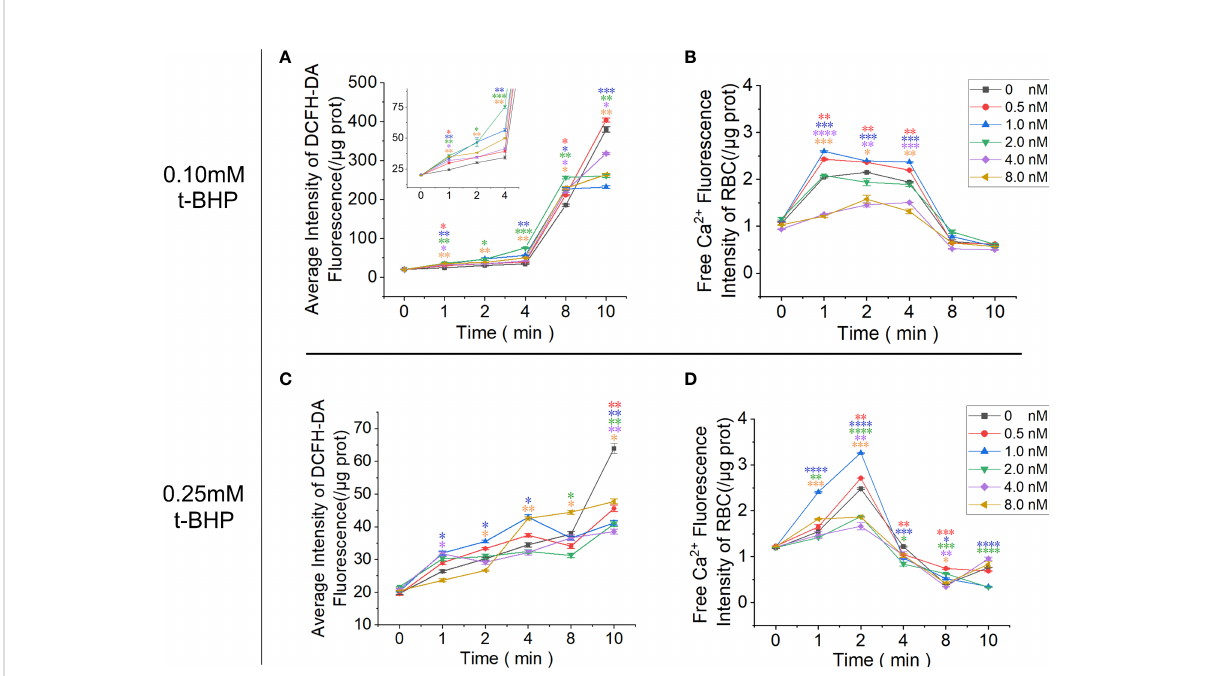
FIGURE 7 Functional analysis of PMCA4 in maintaining calcium homeostasis in RBCs. RBCs were pretreated with different concentrations of Omega- Agatoxin IVA for 10 minutes and then treated with 0.10 mM or 0.25 mM t-BHP for 0, 1, 2, 4, 8 and 10 minutes prior to the detection of the ROS and free calcium levels in RBCs. (A) ROS levels in RBCs after treatment with 0.10 mM t-BHP. (B) Free calcium levels in RBCs after treatment with 0.10 mM t-BHP. (C) ROS levels in RBCs after treatment with 0.25 mM t-BHP. (D) Free calcium levels in RBCs after treatment with 0.25 mM t- BHP. (Error bars represent the mean ± SEM, * P < 0.05, ** P < 0.01, *** P < 0.001, **** P < 0.0001 vs. the 0 nM control group. Refer to Supplementary Tables 5-8 for P values. One-way ANOVA was used for statistical